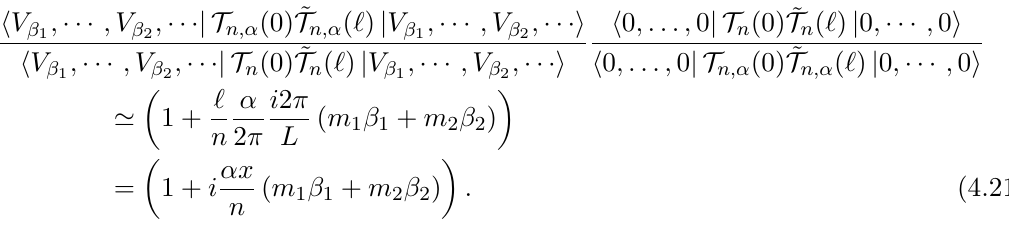
Figure 2 . Excess of the average charge h q i of β ( β = − 2 , − 1 , 1 , 2 ). The universal CFT results, which are linear functions of x , cf. eq. (4.22) are tested against exact numerical result for the XX chain at half-filling ( L = 200